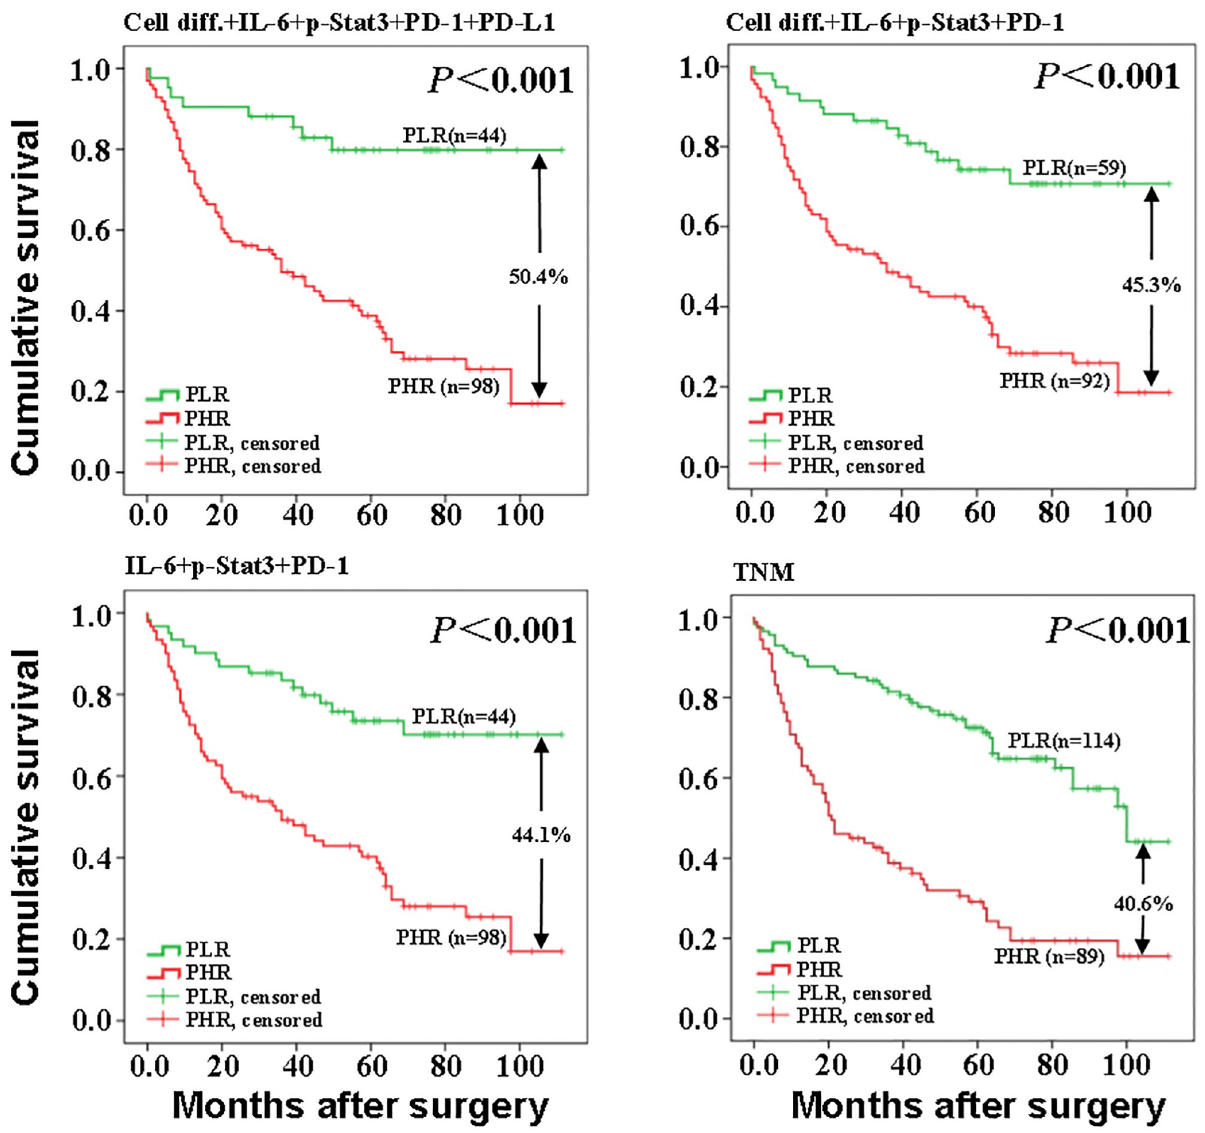
Fig 5. Prediction of low and high risk survival curves in patients with gastric cancer. The joint prediction model in this study was divided into a low mortality risk group (PLR) and a high mortality risk group (PHR), using the Cut-off value as the boundary. The cumulative survival rate of patients with gastric cancer in the low-risk group in combination 1 (81.0%) was higher than that of patients with gastric cancer in the high-risk group (30.6%), with a difference of 50.4%. In combination 2, the cumulative survival rate of gastric cancer patients in the low-risk group (74.6%) was higher than that of gastric cancer patients in the high-risk group (29.3%), with a difference of 45.3%. The cumulative survival rate of gastric cancer patients in the low- risk group (73.8%) in combination 3 was higher than that of gastric cancer patients in the high-risk group (29.7%), with a difference of 44.1%. The cumulative survival rate of gastric cancer patients in the low-risk group in combination 5 (TNM) (64.0%) was higher than that of gastric cancer patients in the high-risk group (23.6%), with a difference of